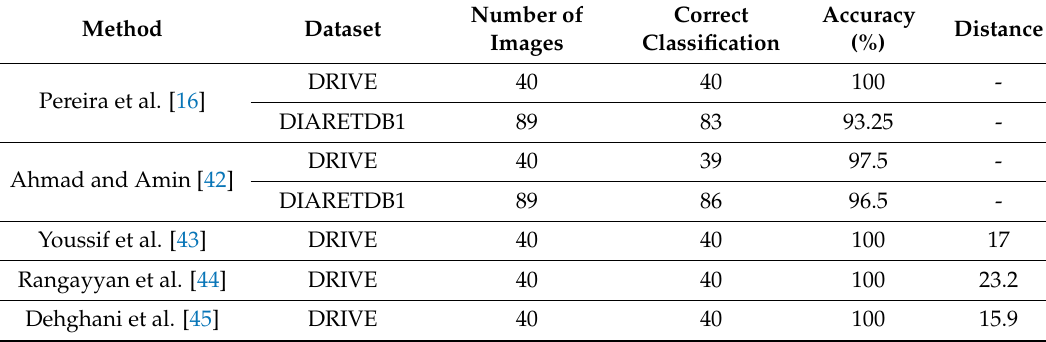
Table 2. A comparative analysis of the results of the proposed method and other methods in the